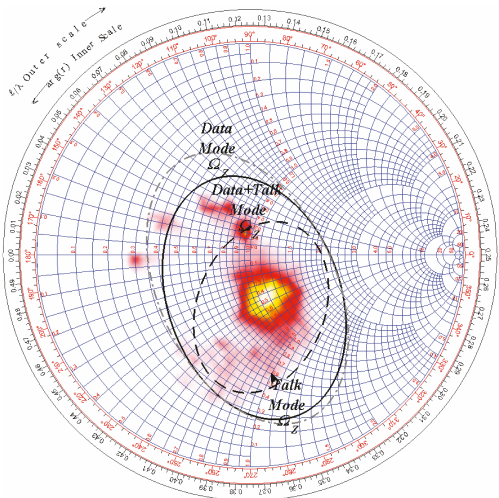
Figure 8: Comparison of talk, data, and fi nal uncertainty impedance ellipse in UTRA/FDD LTE B8 band for a T- monopole antenna.